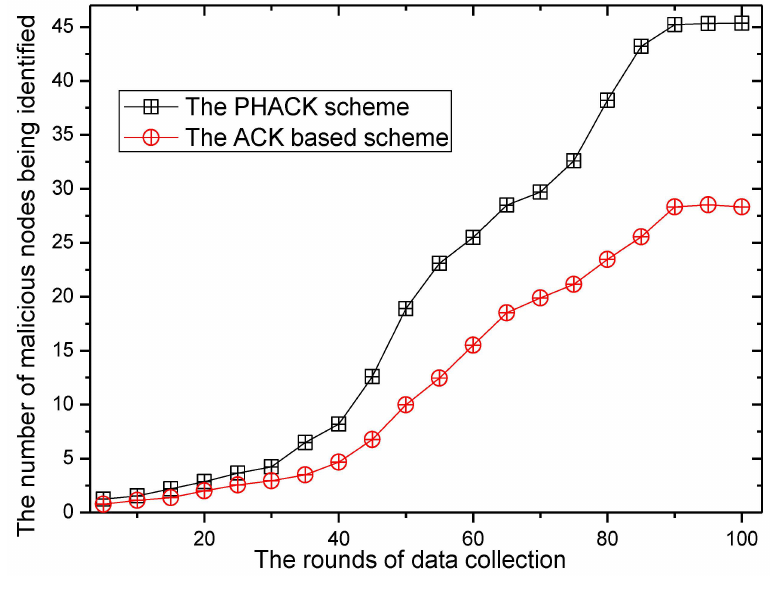
Figure 20. The number of malicious nodes being identified.